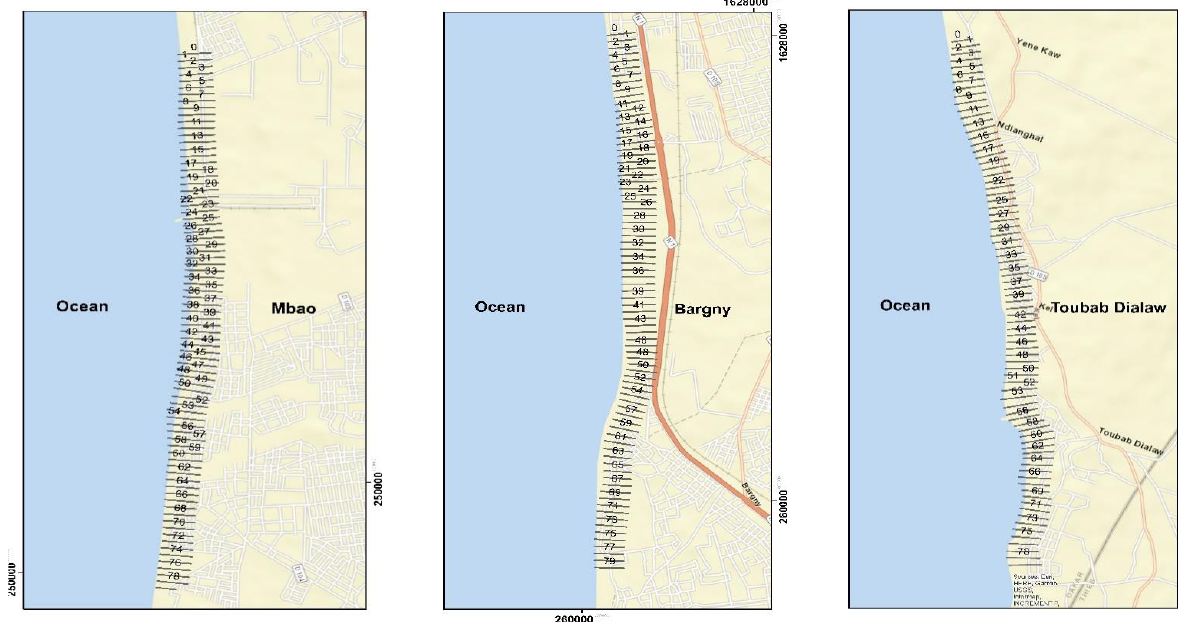
Figure 6. Transect considerations in Mbao, Bargny and Toubab Dialaw littoral cells.